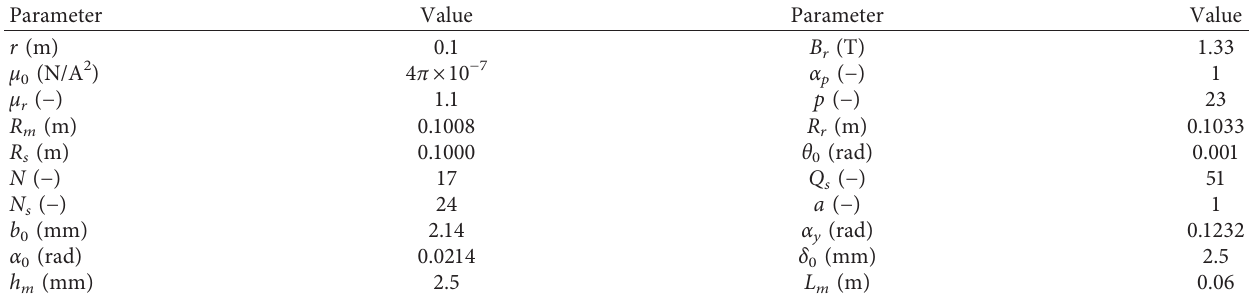
Table 2: Parameters of the outer-rotor PMBLDC